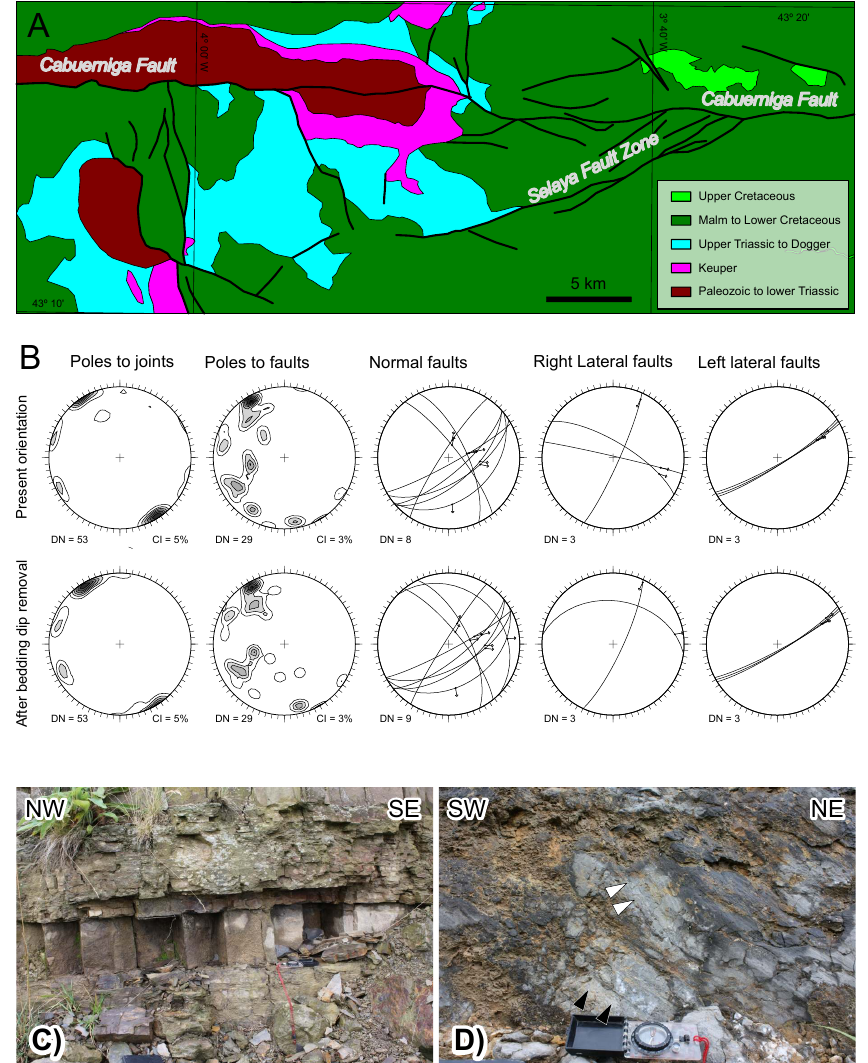
Fig. 15. (A) Geological map of the Selaya Fault System. (B) Mesostructural data collected along the northeastern termination of the fault system. (C) Bedding-perpendicular orthogonal joint sets. (D) Detail of a SW-NE striking almost dip-slip extensional fault (white arrows) later reactivated as a left-lateral transtensive element (black